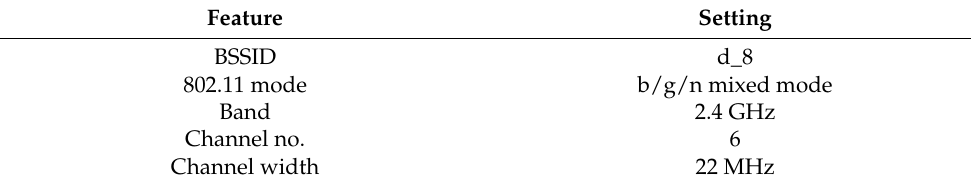
Table 2. General settings used for the D-Link